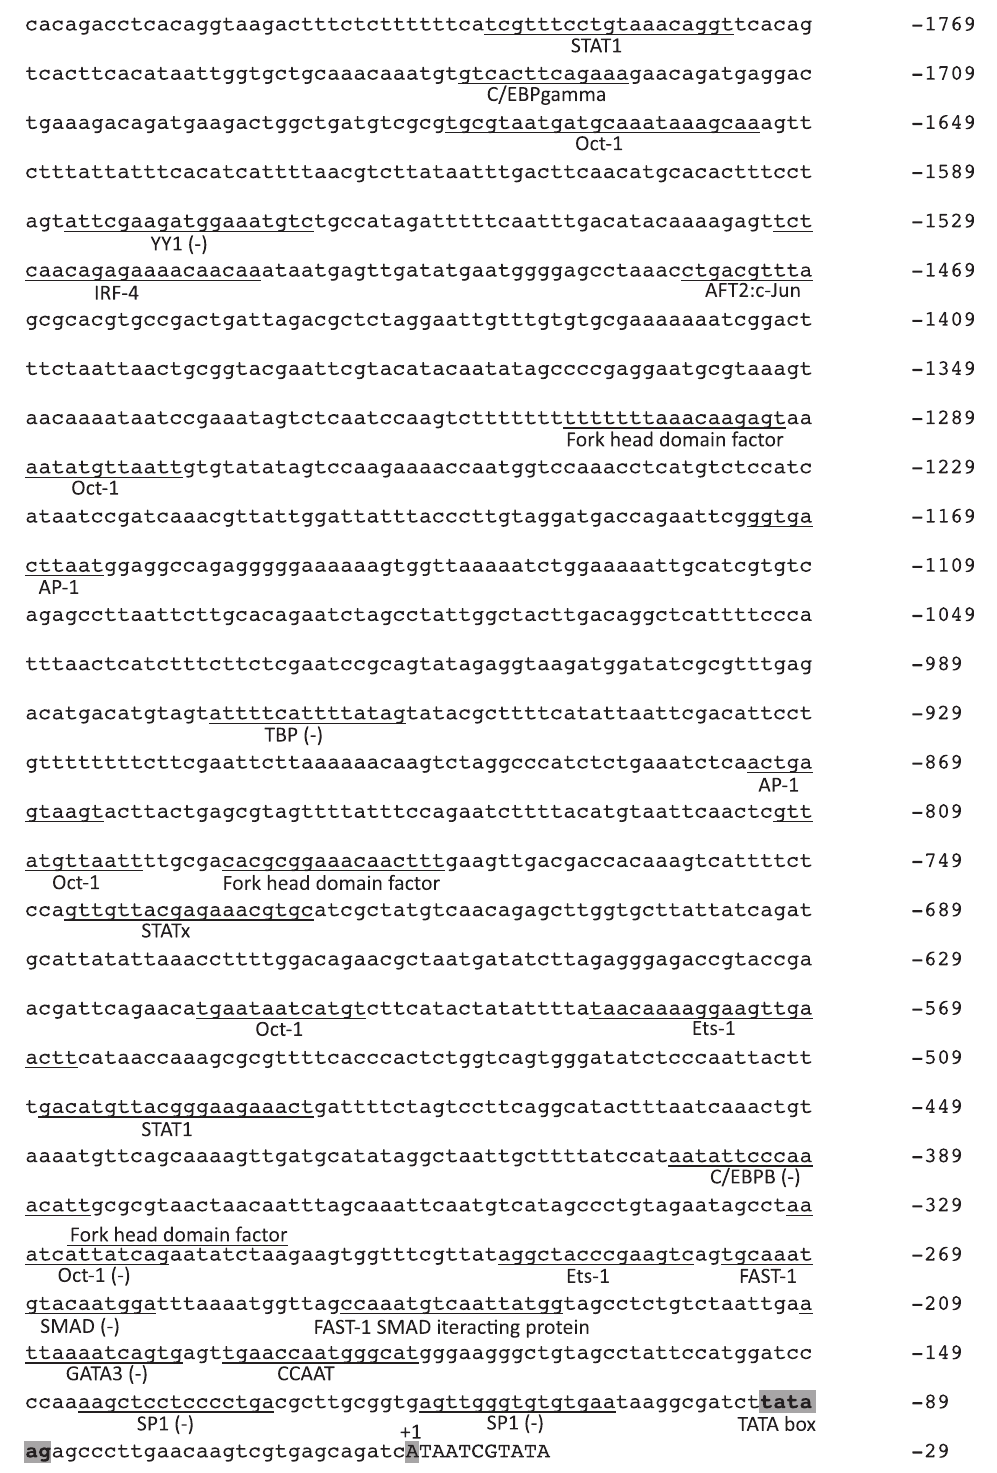
Figure 2. Atlantic salmon Eomes promoter sequence with consensus transcription factor binding sites. The consensus transcription binding sites were predicted by MatInspector and TRANSFAC. Putative transcription factor binding sites are underlined, while ( 2 ) sign indicates the binding sites identified on the negative strand. TATA box and transcription start site ( + 1) are shaded. doi:10.1371/journal.pone.0055893.g002 responses, we utilized challenge model based study with A. different time intervals following bacterial and viral infection in the salmonicida and IPN virus. We first examined the mRNA spleen and head kidney. expression levels of AsEomes, IFN c , CD8 a , and granzyme A at